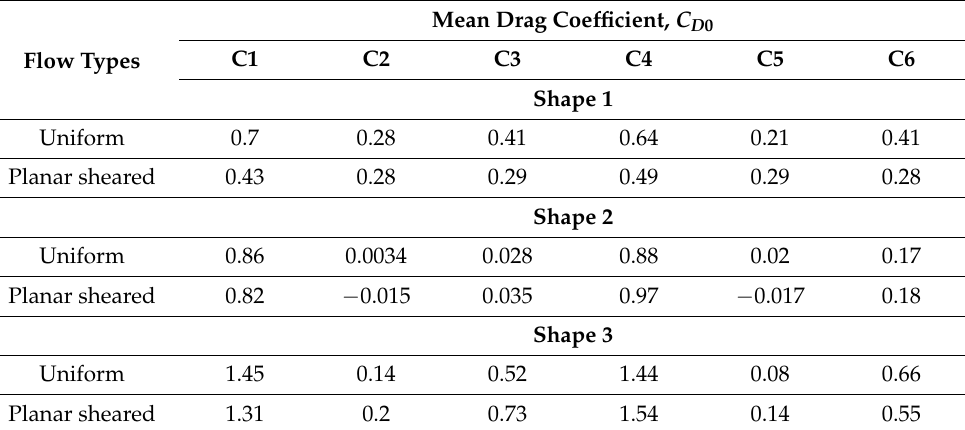
Table 3. Mean drag coefficients for six structures in a group for three cross-sectional shapes and two types of